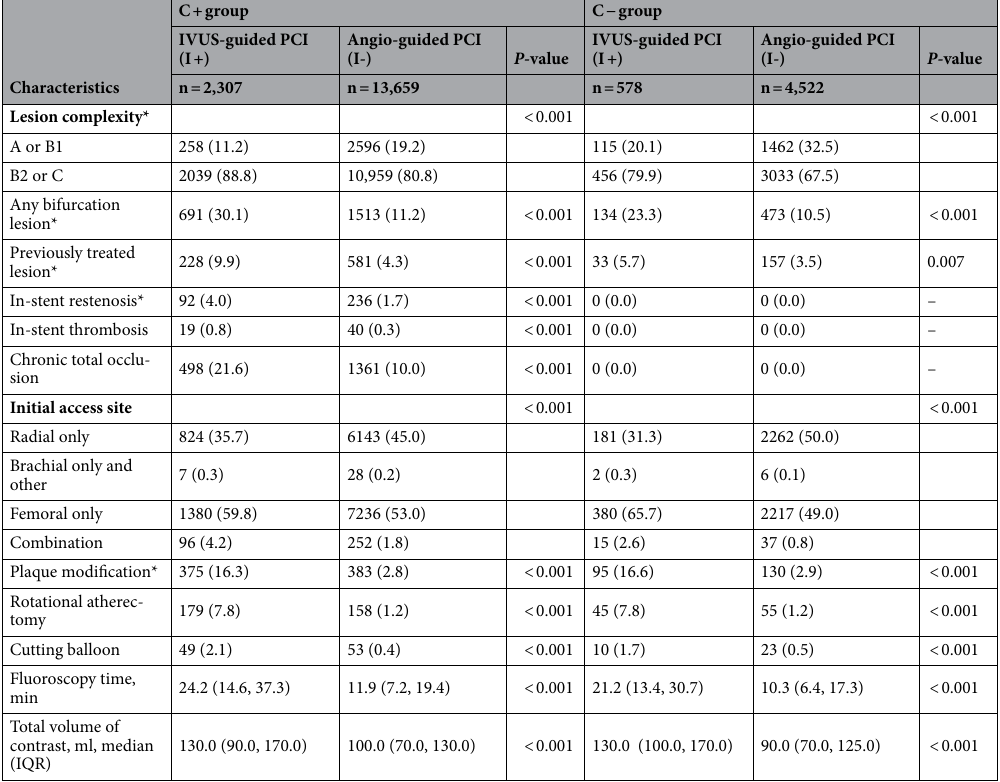
Table 2. Lesion and procedural characteristics. *There are missing data, percentage is calculated based on total numbers where data is available. Values are expressed as n (%) or mean ± SD or median (interquartile 1st, 3rd). Abbreviations : C + , met criteria; C−, unmet criteria; IVUS, intravascular ultrasound; I + , IVUS-guided PCI, I−, angio-guided PCI; IQR, interquartile range; PCI, percutaneous coronary